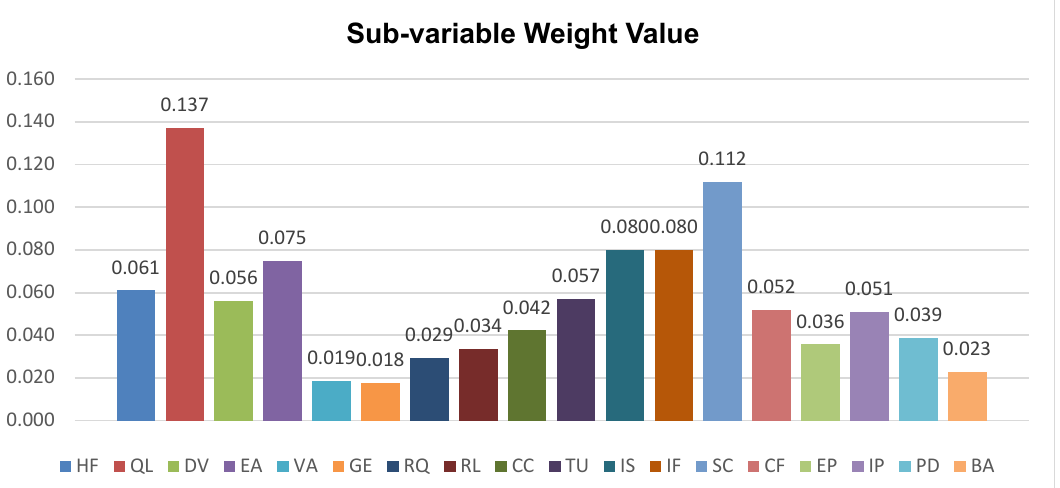
Fig. 4. Global weight of Sub-variable vulnerability of TNI-Polri